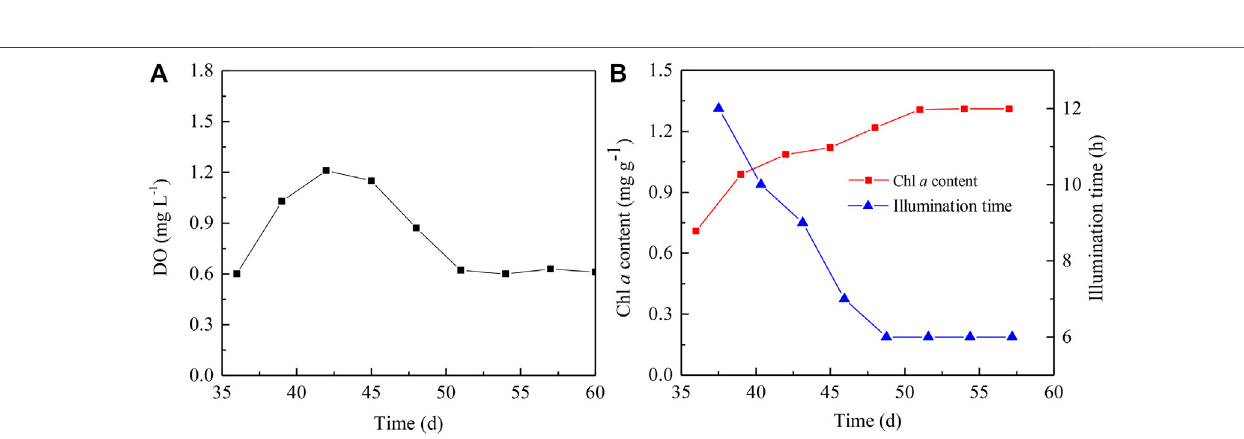
Frontiers in Bioengineering and Biotechnology |